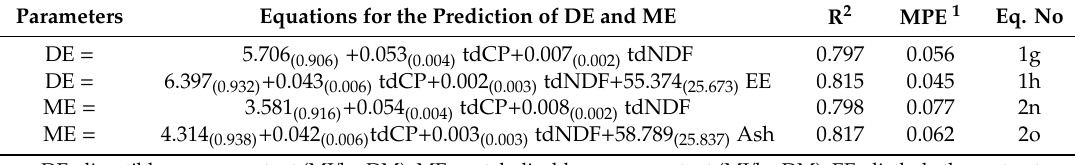
Table 5. Prediction equations for herbage DE and ME concentrations using total digestible nutrient concentration and chemical composition